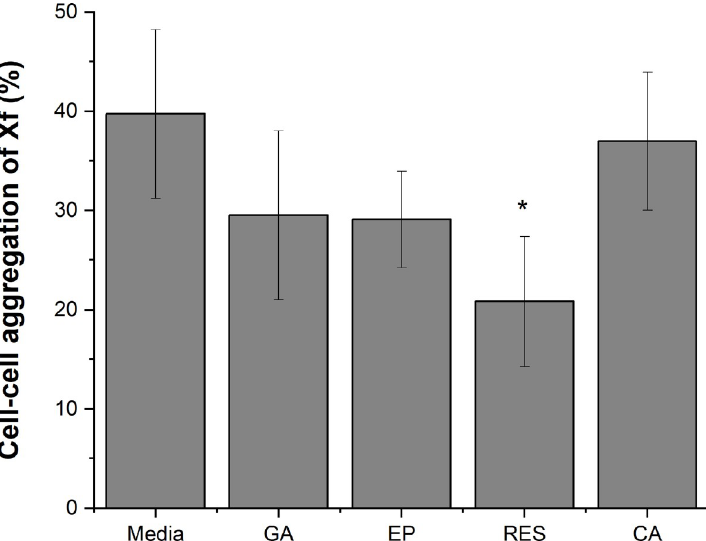
Fig 2. Resveratrol reduces cell-cell aggregation of X . fastidiosa . Percent cell–cell attachment of cells treated with gallic acid (GA), epicatechin (EP), resveratrol (RES), or coumaric acid (CA) for 7 d. Media was supplemented with GA (1000 μ g/ml), EP (200 μ g/ml), RES (15 μ g/ml), or CA (60 μ g/ml). Data are expressed as mean ± standard deviation of two independent experiments ( n = 6). Significant differences (p-value < 0.005) in attachment ratio were determined by One-way ANOVA followed by Dunnett’s test comparing treatments to the media control and are indicated by asterisk.